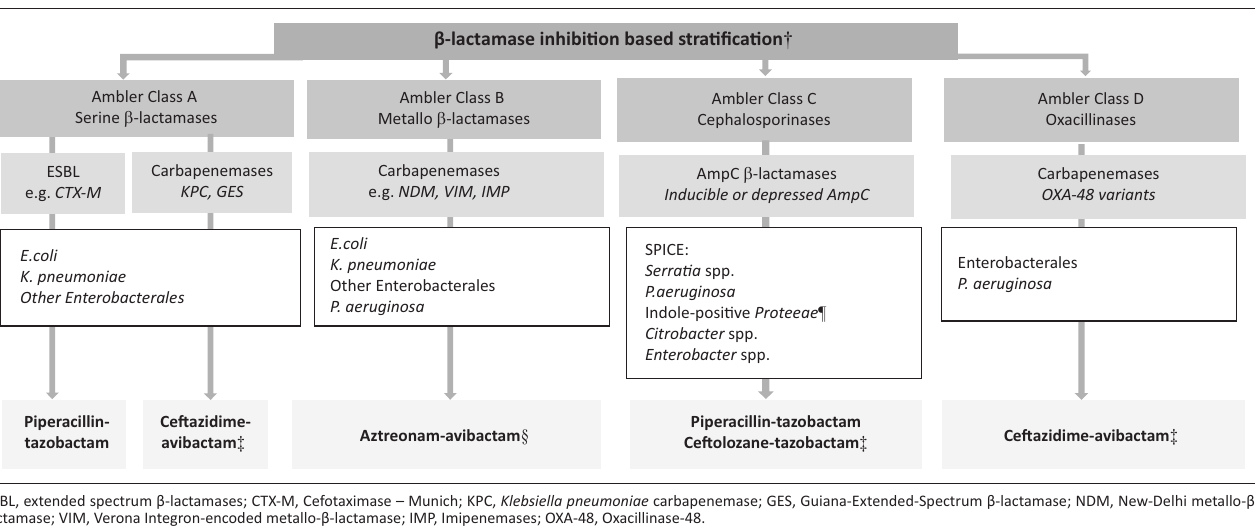
FIGURE 1: Conceptual approach to β-lactamase inhibitor therapy for severe